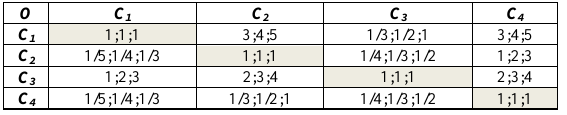
Table 1. Matrix of pairwise comparisons of the criteria in relation to the overall objective